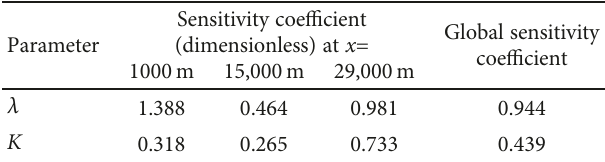
Table 5: Sensitivity coe ffi cients of subsurface temperature at x =1000m, 15,000m, and 29,000m to aquifer thermal di ff usivity ( λ ) and hydraulic conductivity ( K